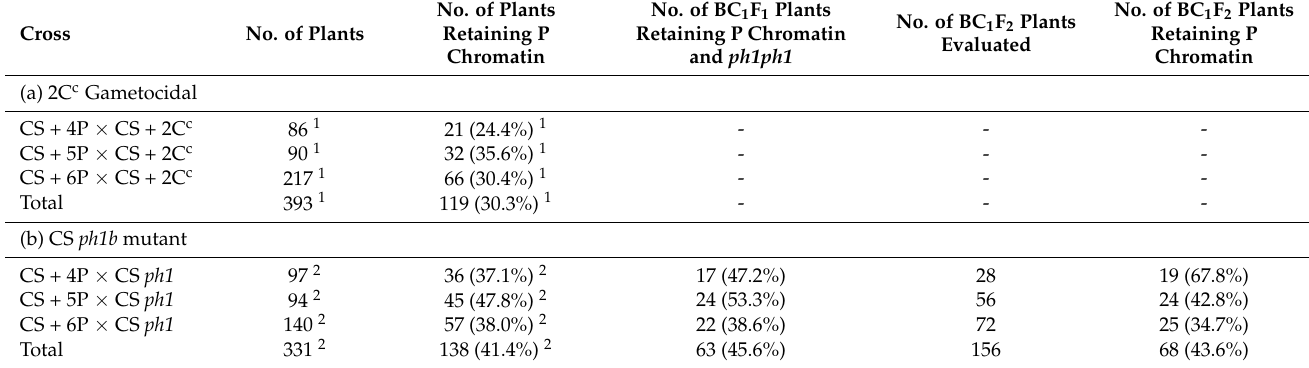
Table 1. Progeny retaining A. cristatum chromatin. (a) F 2 plants from crosses between the disomic addition line for chromosomes 4P, 5P and 6P, respectively, and the CS disomic addition line for gametocidal 2C c chromosome; (b) BC 1 F 1 and BC 1 F 2 plants from crosses between the disomic addition line for chromosomes 4P, 5P and 6P, respectively, and CS ph1